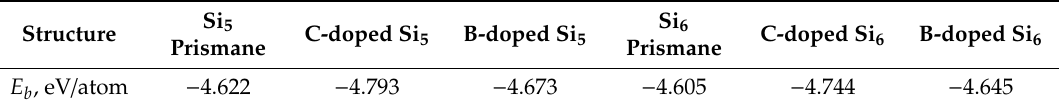
Table 1. The binding energy values for the pure Si 5 and Si 6 silicon prismanes and their carbon and boron-doped